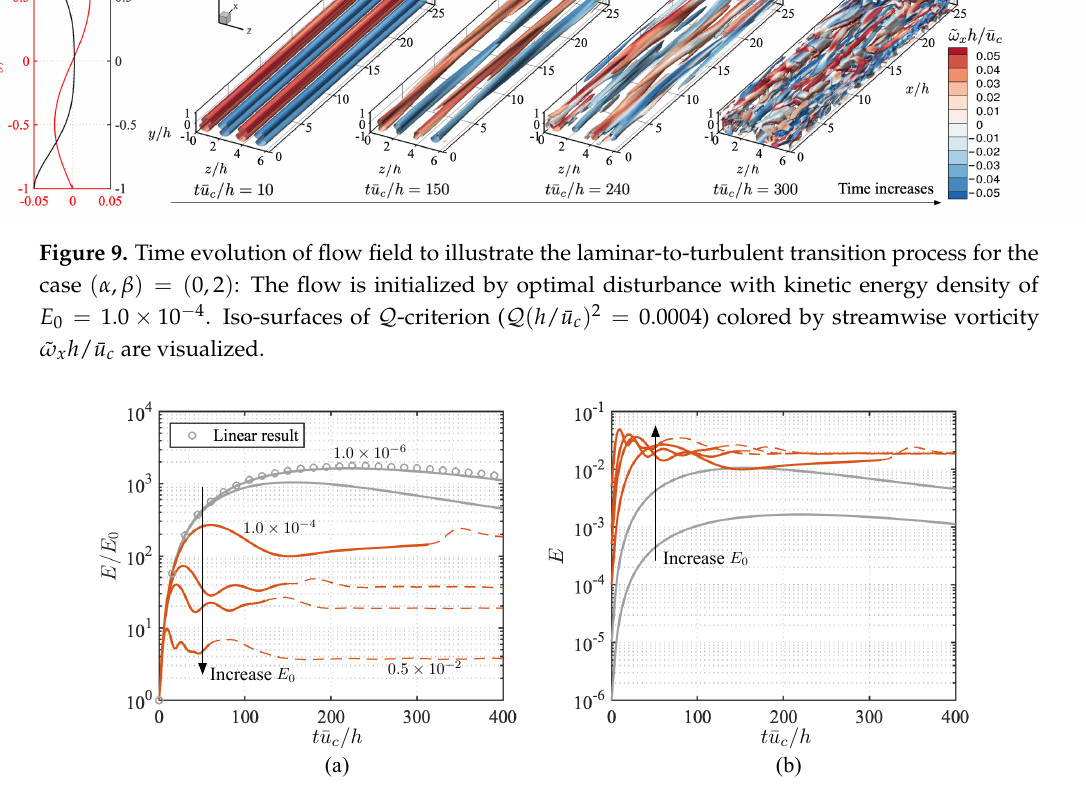
Figure 10. Time evolution of kinetic energy density E of case ( α , β ) = ( 0,2 ) initialized by different amplitudes of optimal disturbance E 0 : Red lines represent transition cases, and grey lines denote that the flow remains laminar. Dashed line indicates that the flow is in turbulent state. ( a ) Kinetic energy density normalized by its initial value E / E 0 and ( b ) kinetic energy density E .